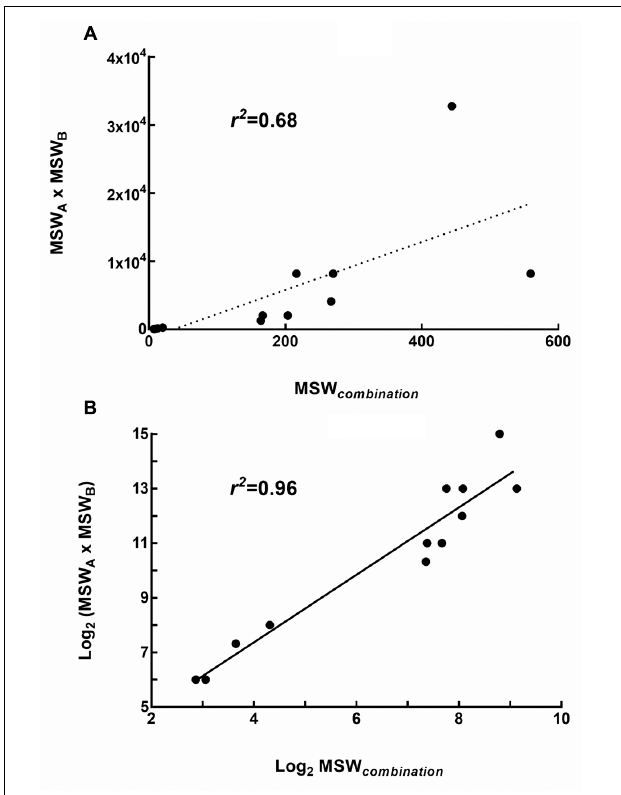
FIGURE 5 | Relationship between the MSW of single drugs and the MSW of drug combinations (MSW combination ). (A) Correlation between MSW combination and the product of MSW of each single drug (MSW A × MSW B ); (B) Correlation between log2 MSW combination and log2 (MSW A × MSW B ).